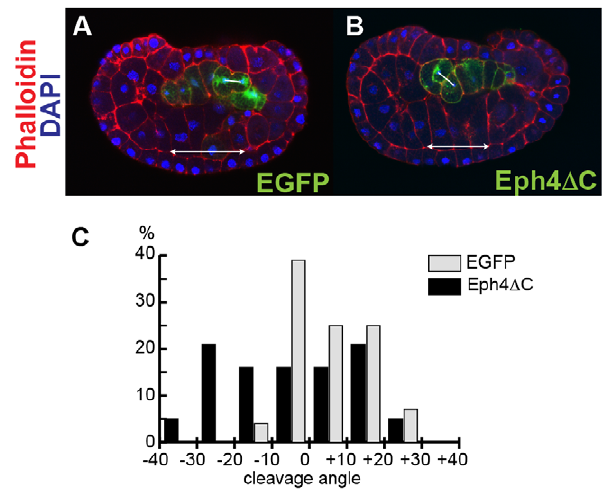
Figure 7. Eph4 D C alters the cleavage angle of notochord cells. (A–B) The cleavage angle in cells expressing EGFP (A) or Eph4 D C (B). Cells expressing transgenes were visualized with EGFP signal (green in A) or staining for myc-tag connected to Eph4 D C (green in B). Embryos were stained for phalloidin (red) and DAPI (blue). Confocal sagittal section images were shown. Anterior is to the left. The angle between a line connecting two centrosomes (lines) in a dividing cell and a line along the basal surface of ventral epidermis (arrows) was measured. (C) Distribution of the cleavage angle in cells expressing EGFP or Eph4 D C. Samples were grouped based on their cleavage angle and % of each group was shown in a graph.